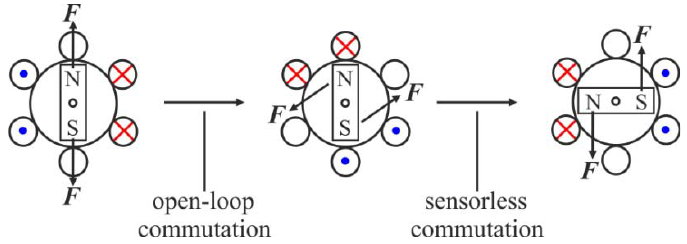
Figure 21. Open-loop starting procedure